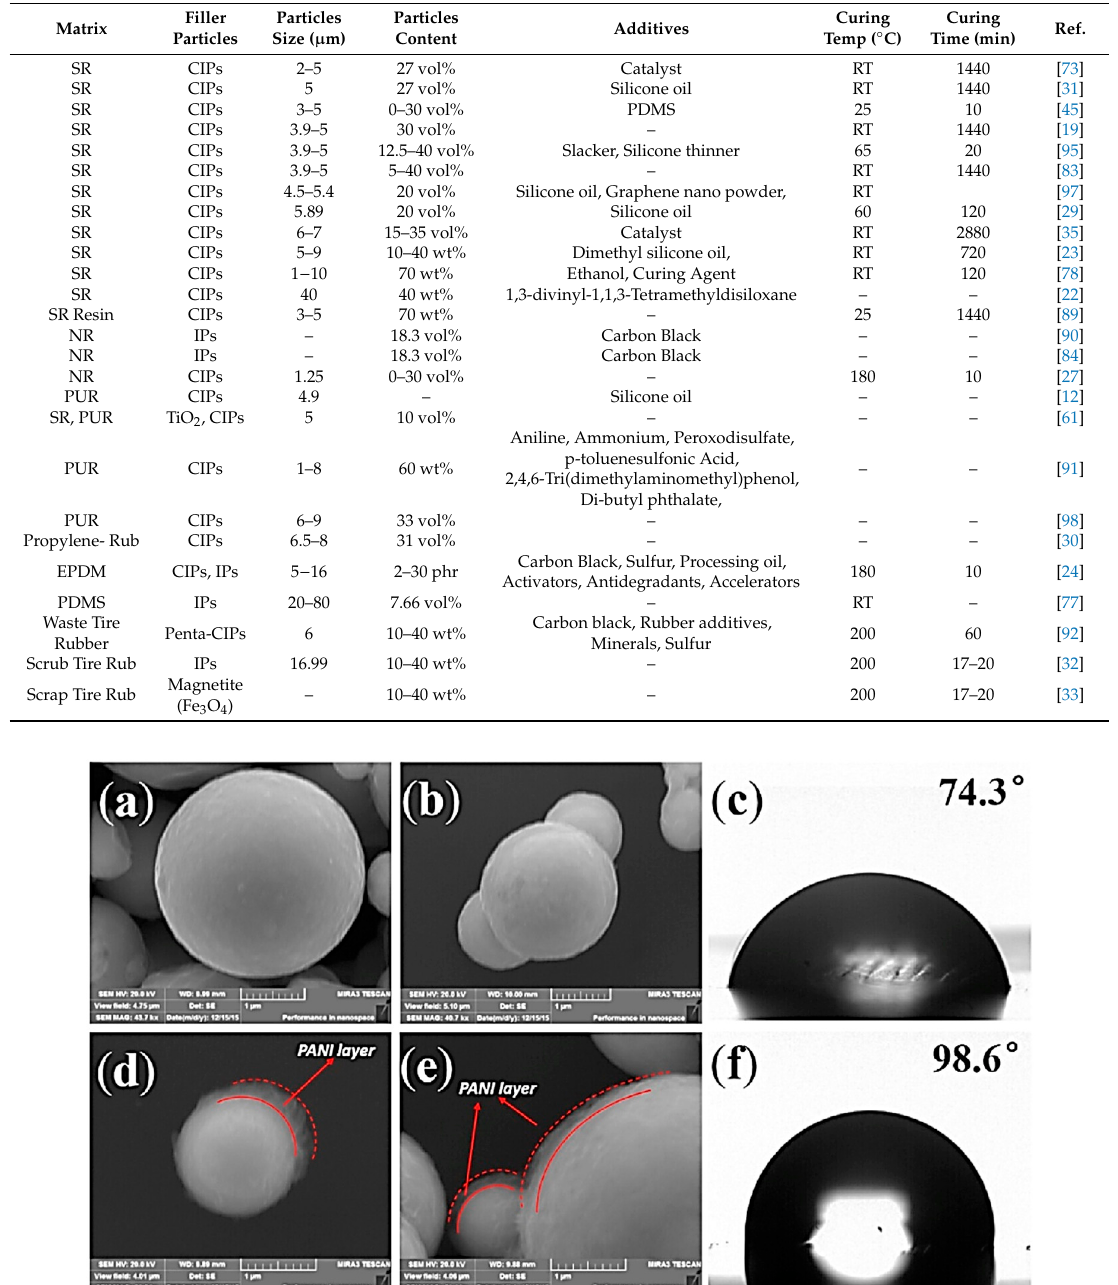
Figure 3. SEM micrographs of ( a , b ) pure CIPs and ( d , e ) PANI-modified CIPs; contact angles of a water droplet on ( c ) pure CIPs and ( f ) PANI-modified CIPs [91] (reprinted with permission from Elsevier TM ).